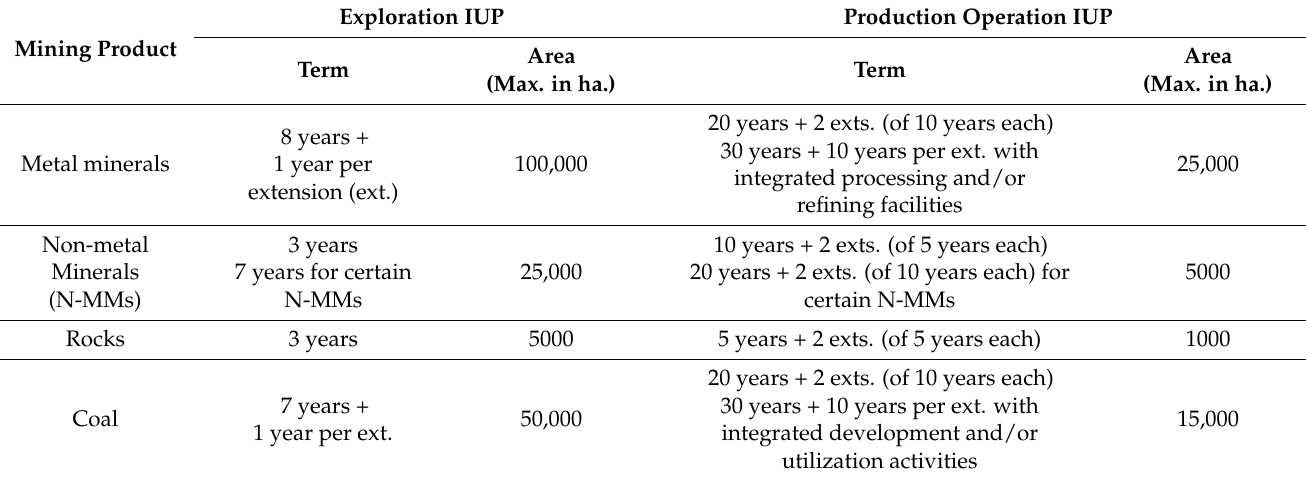
Table 1. Terms by mining